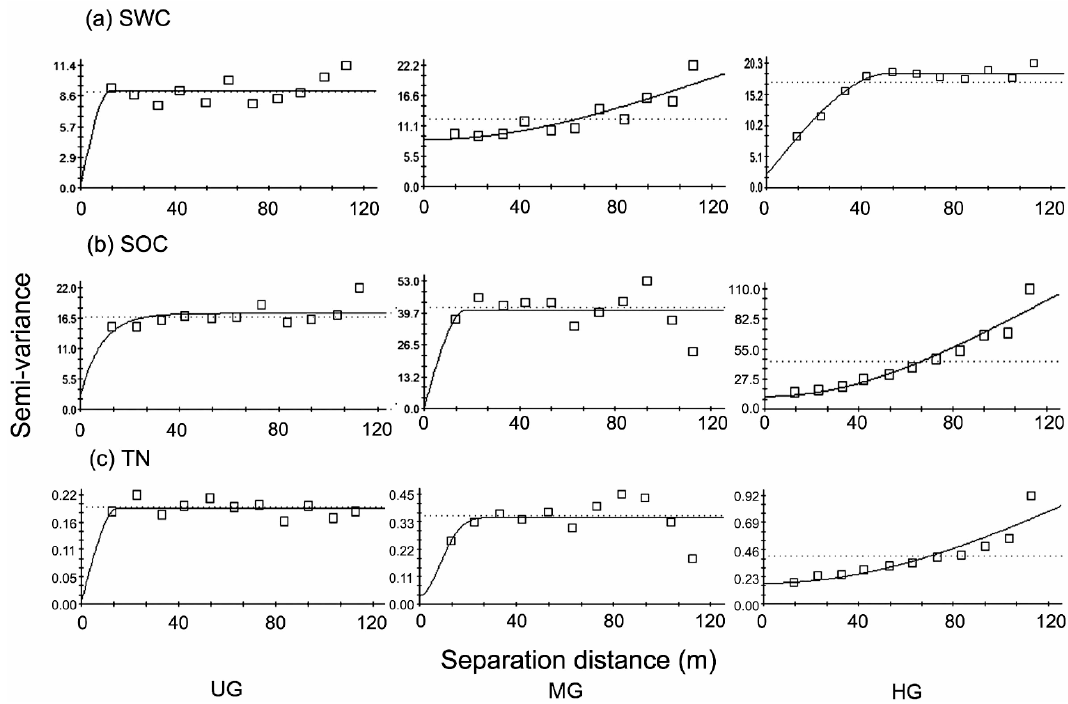
Figure 6. Semivariograms for soil water content (SWC) (a) , soil organic C (SOC) (b) , soil total N (c) for sites exposed to three grazing intensities: ungrazed (UG, first column), moderate grazing (MG, second column) and heavy grazing (HG, third column). Table 3. Summary of semivariogram model parameters for ungrazed (UG), moderate grazing (MG) and heavy grazing (HG) sites. Property Site